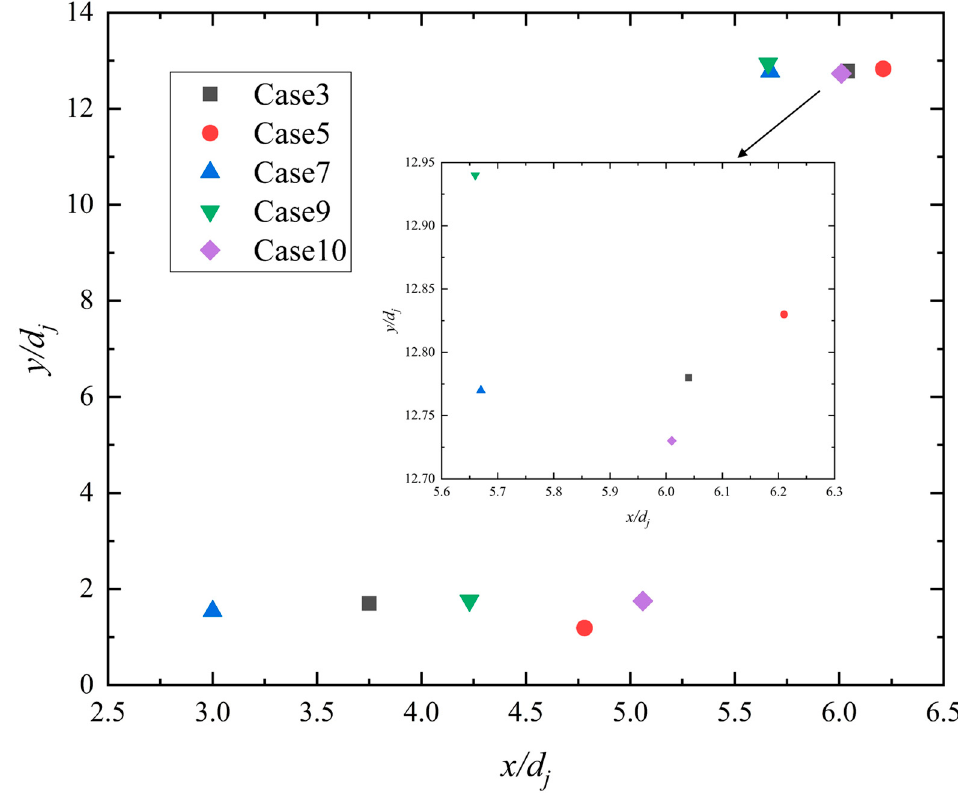
Figure 19. Coordinate comparison of mixing length in various